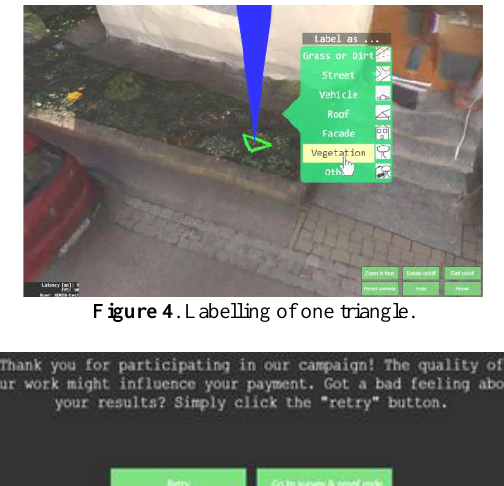
Figure 5 . After completing a crowd job, the crowdworkers are asked if they want to repeat the